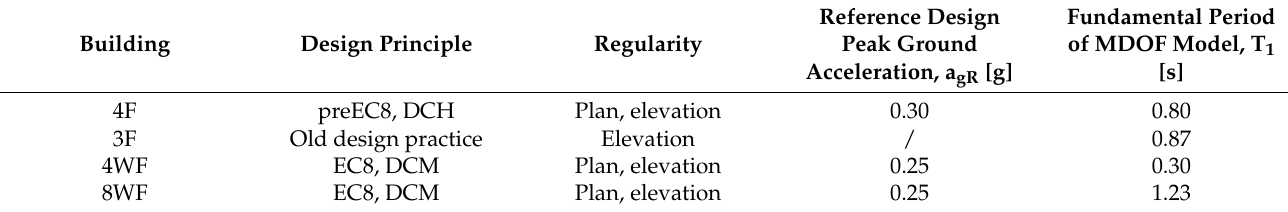
Figure 5. The elevation and plan views of the analyzed 4F, 3F, 4WF, and 8WF buildings. Table 1. The principles of seismic design, the regularity of investigated buildings’ structural system, the reference design peak ground acceleration (a gR ), and the fundamental periods of the MDOF models (T 1